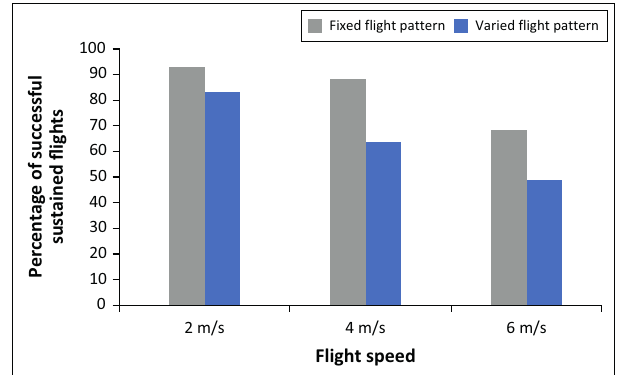
FIGURE 2 : The percentage of successful approaches, regardless of elephant category, when broken down by Approach Speed (2 m/s, 4 m/s or 6 m/s), Angle of Approach (45 ° or 90 °) and Starting Altitude (30 m, 50 m or 100 m). TABLE 4: The breakdown in effort for presence flights. Elephant type